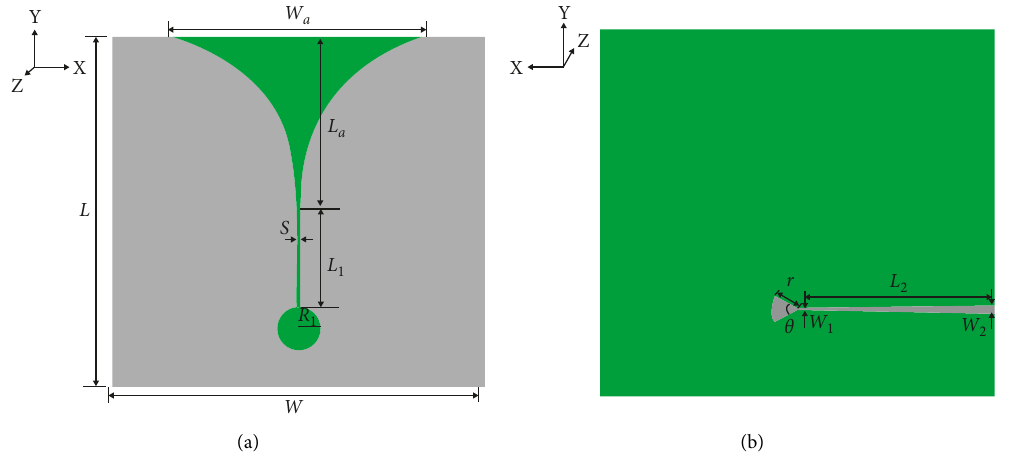
Figure 1: Structure of conventional Vivaldi antennas: (a) front; (b) back.